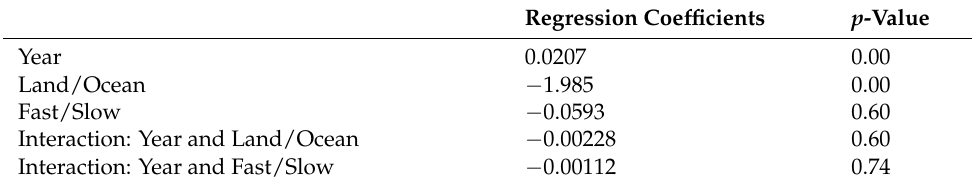
Table 1. Statistical modeling of the number of extreme translation events as a function of year, land/ocean (dummy variable) and fast/slow movement (dummy variable). The interactions between year and land/ocean, and between year and fast/slow are considered in the statistical